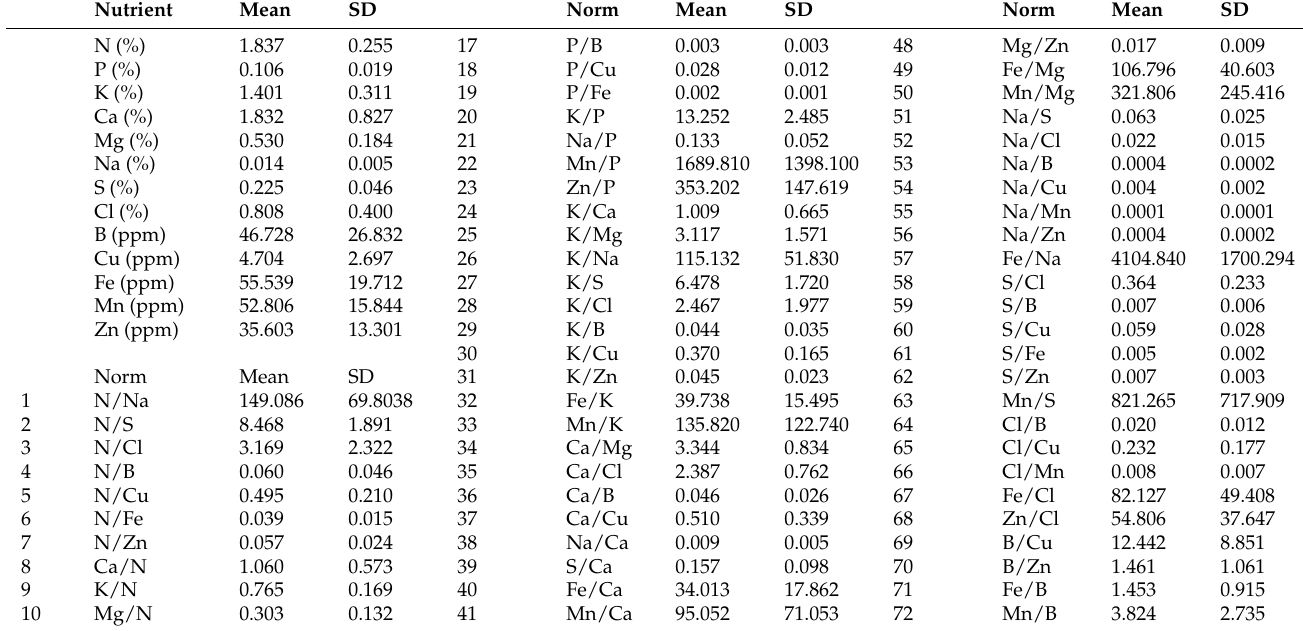
Table 1. Diagnosis and Recommendation Integrated System (DRIS) norms and standard deviations (SD) obtained from the nutrient contents of foliar samples from a high-yielding population of ‘Rojo Brillante’ persimmon, PDO ‘Kaki Ribera del X ú quer’,